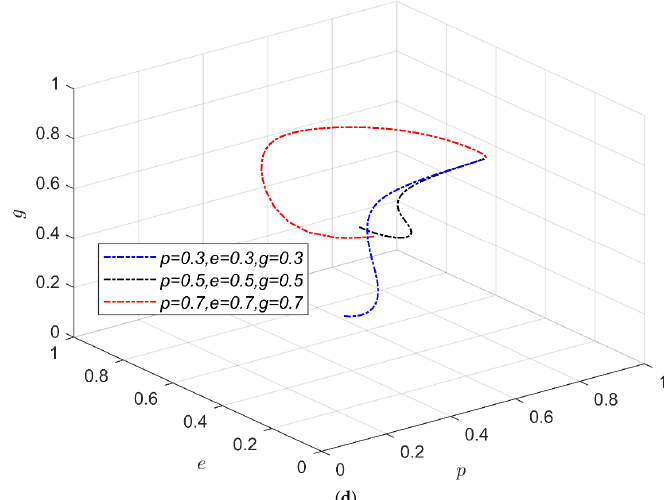
Figure 1. ( a ) Evolution path diagram under static reward and static penalty mechanism, ( b ) Evolution path diagram under dynamic reward and static punishment mechanism, ( c ) Evolution path diagram under static reward and dynamic punishment mechanism, ( d ) Evolution path diagram under dynamic reward and dynamic punishment mechanism.